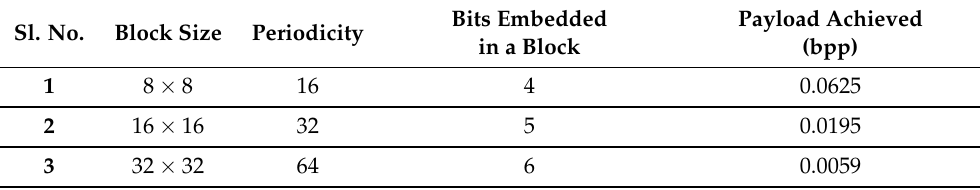
Table 1. Relation between the periodicity of the Fibonacci transform and the block size. Sl.